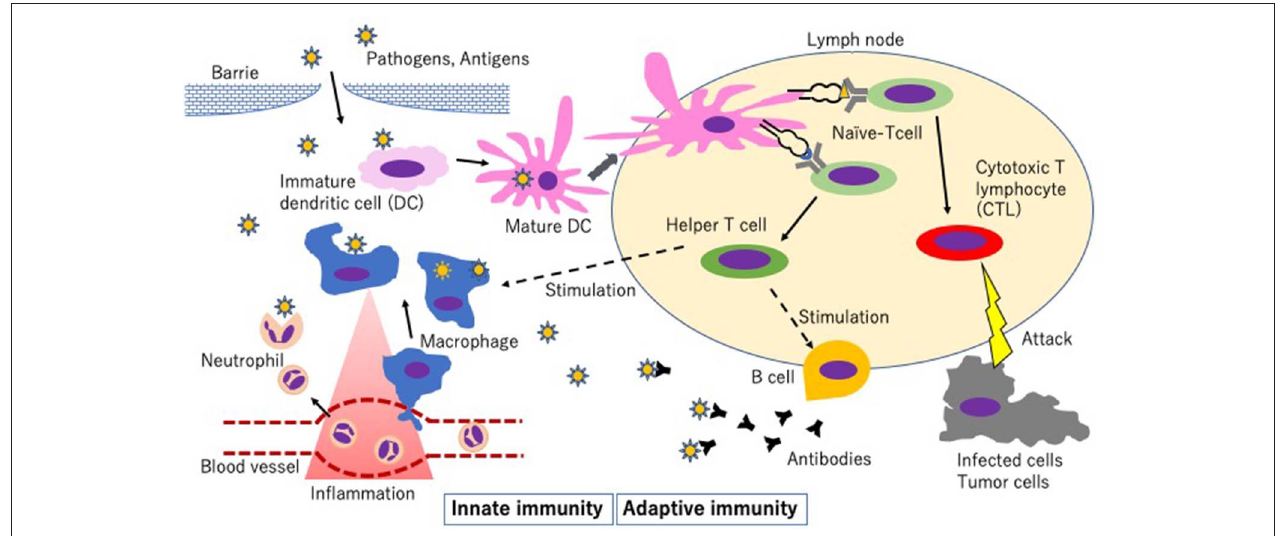
FIGURE 2 | Schematic diagram of innate immunity and adaptive immunity. Step 1: Activation of pattern recognition receptors (PRRs) on tissue-resident macrophages and/or dendritic cells (DCs) by pathogen-associated molecular patterns (PAMPs) resulting in activation of the innate immune response and the following events. 1. Migration of monocytes that mature into recruited macrophages and neutrophils in the systemic circulation. 2. Maturation of DCs, which then migrate to the lymph node. Step 2: Processing of the antigens and presentation of an antigen on major histocompatibility complex I (MHC-I) or MHC-II to the T cell receptor on T cells. Step 3: Development of adaptive